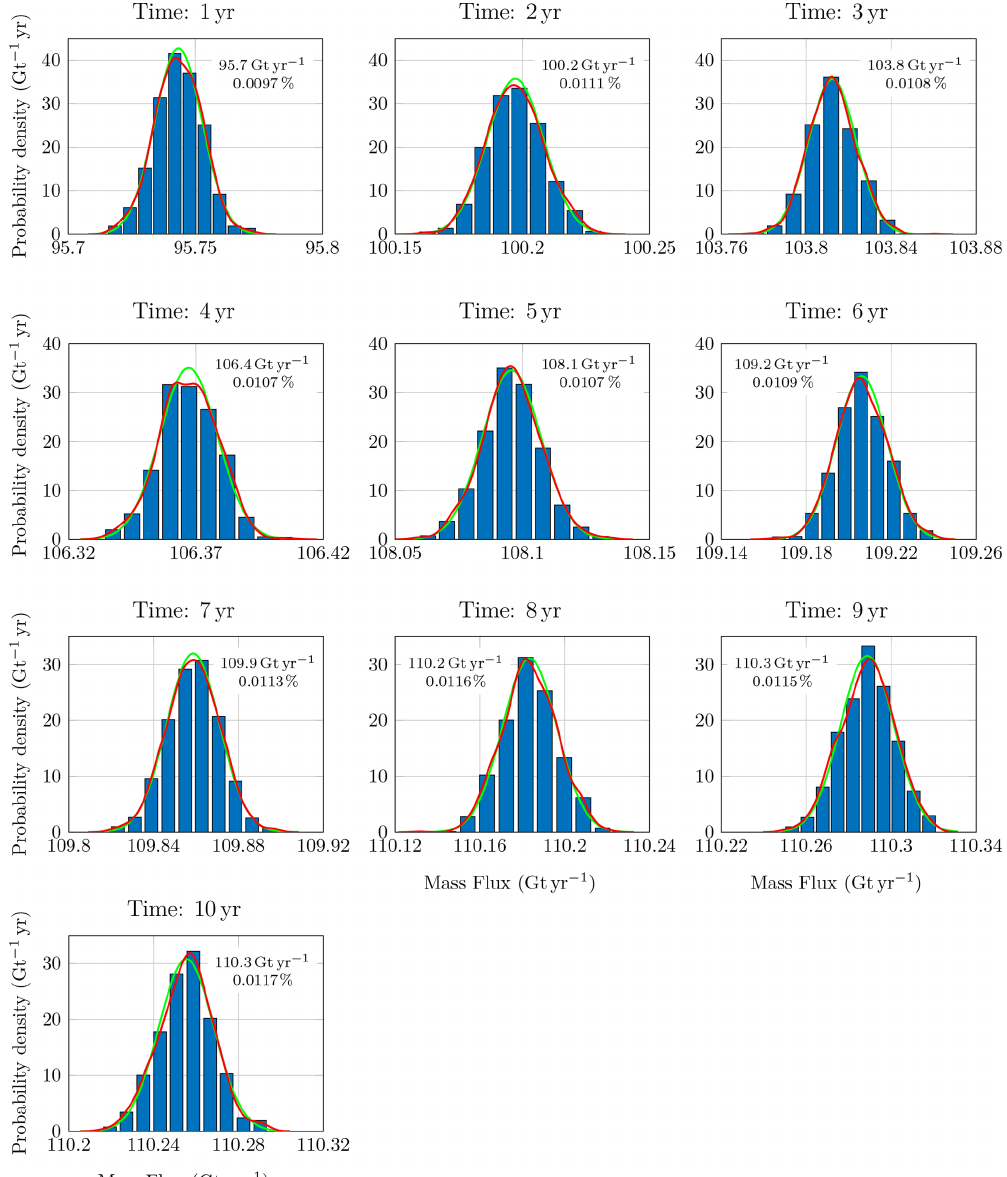
Figure 16. Normalized histograms for mass flux across fluxgate 3 (see Fig. 5) as a function of time. The mean (in Gtyr − 1 ) and the coefficient of variation (in percent) are provided for each time. The kernel density estimate of the probability density function is shown in red, and its Gaussian approximation with corresponding mean and coefficient of variation is shown in green. Results are for a parameter range of 30km and a temporal correlation of